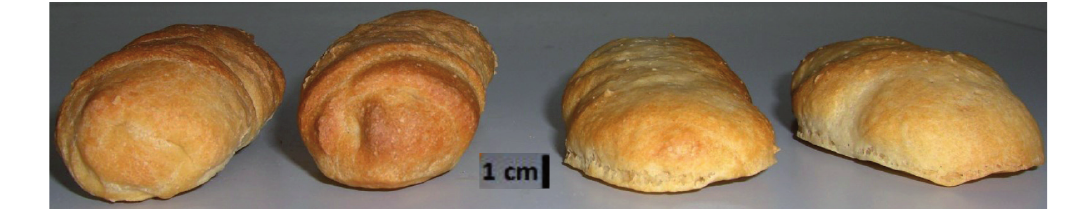
Fig. 7: Bread loaves prepared from flour Type 550 fulfilling (left) and highly exceeding (right) EU maximum level of DON for flour, k reuZBerger (